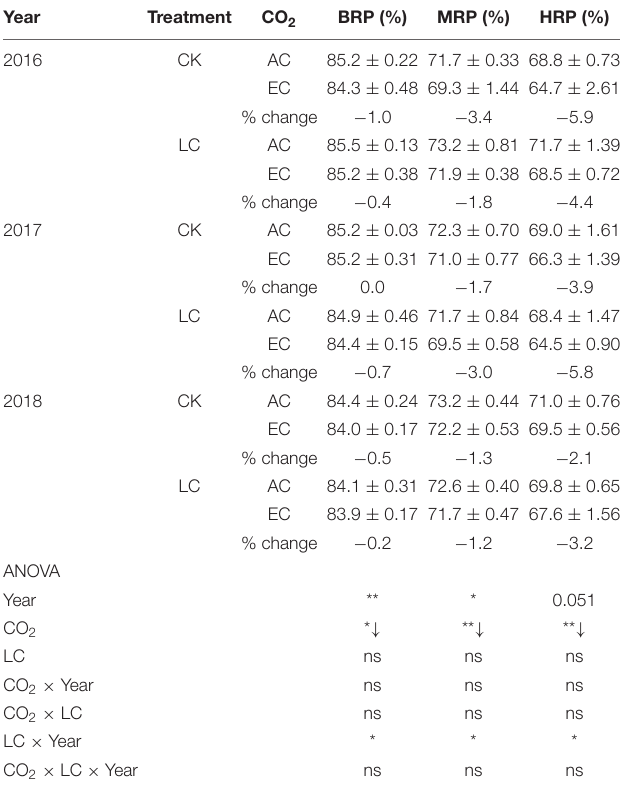
FIGURE 1 | Chalky grain percentage (A) and chalkiness degree (B) of WYJ27 as affected by elevated CO 2 under CK (no leaf cutting) and LC (cutting off top three leaves) across three cropping seasons (2016–2018). Each bar in the figure represents the mean values across three plots for ambient CO 2 (AC, filled square) or elevated CO 2 (EC, AC + 200 ppm, unfilled square); vertical bars represent standard error ( n = 3). Statistically significant effects are indicated as ∗∗ P < 0.01; ∗ P < 0.05; + P < 0.1; ns, not significant.